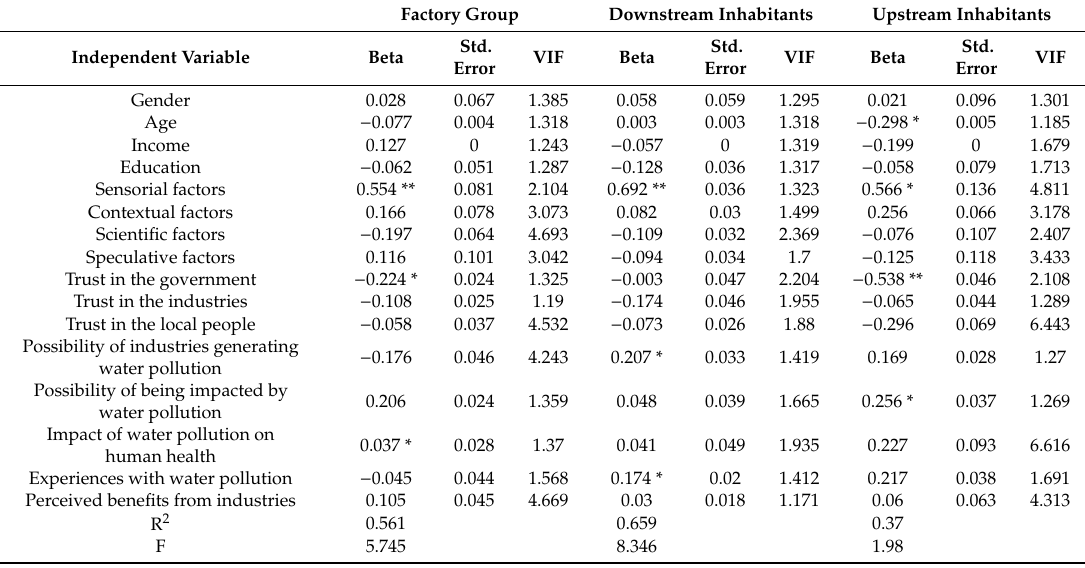
Table 7. Results of regression analyses of predictor variables for environmental risk